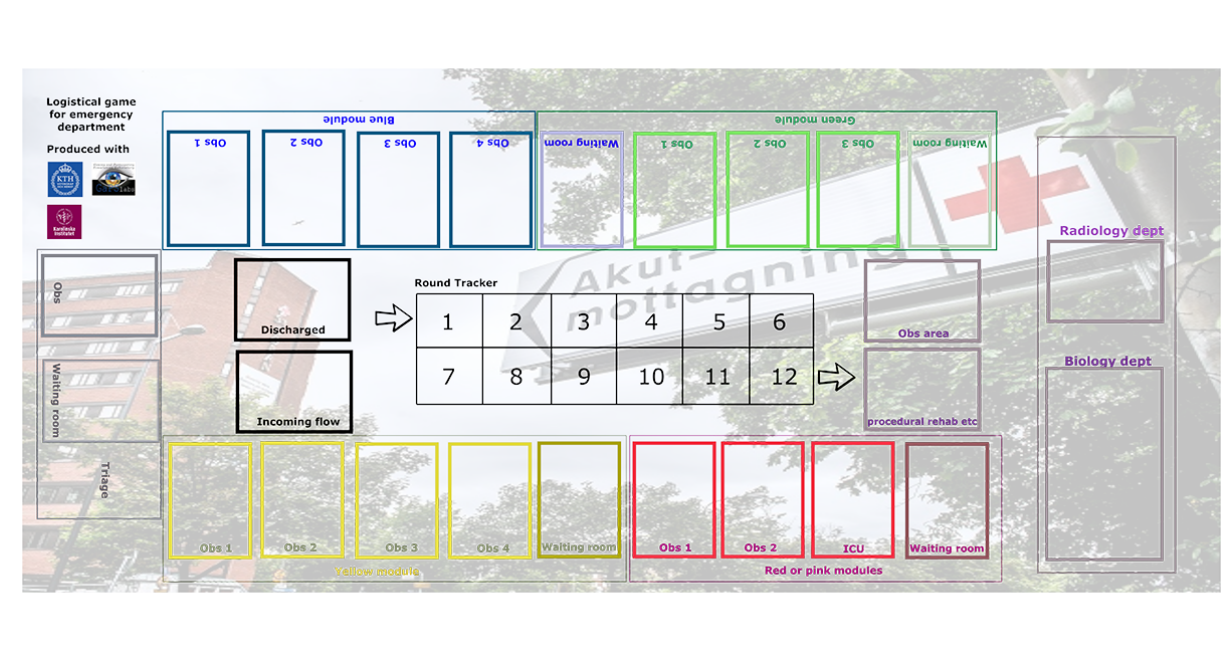
Figure 3. Sandbox game for simulating emergency medicine. Dept: department; obs: